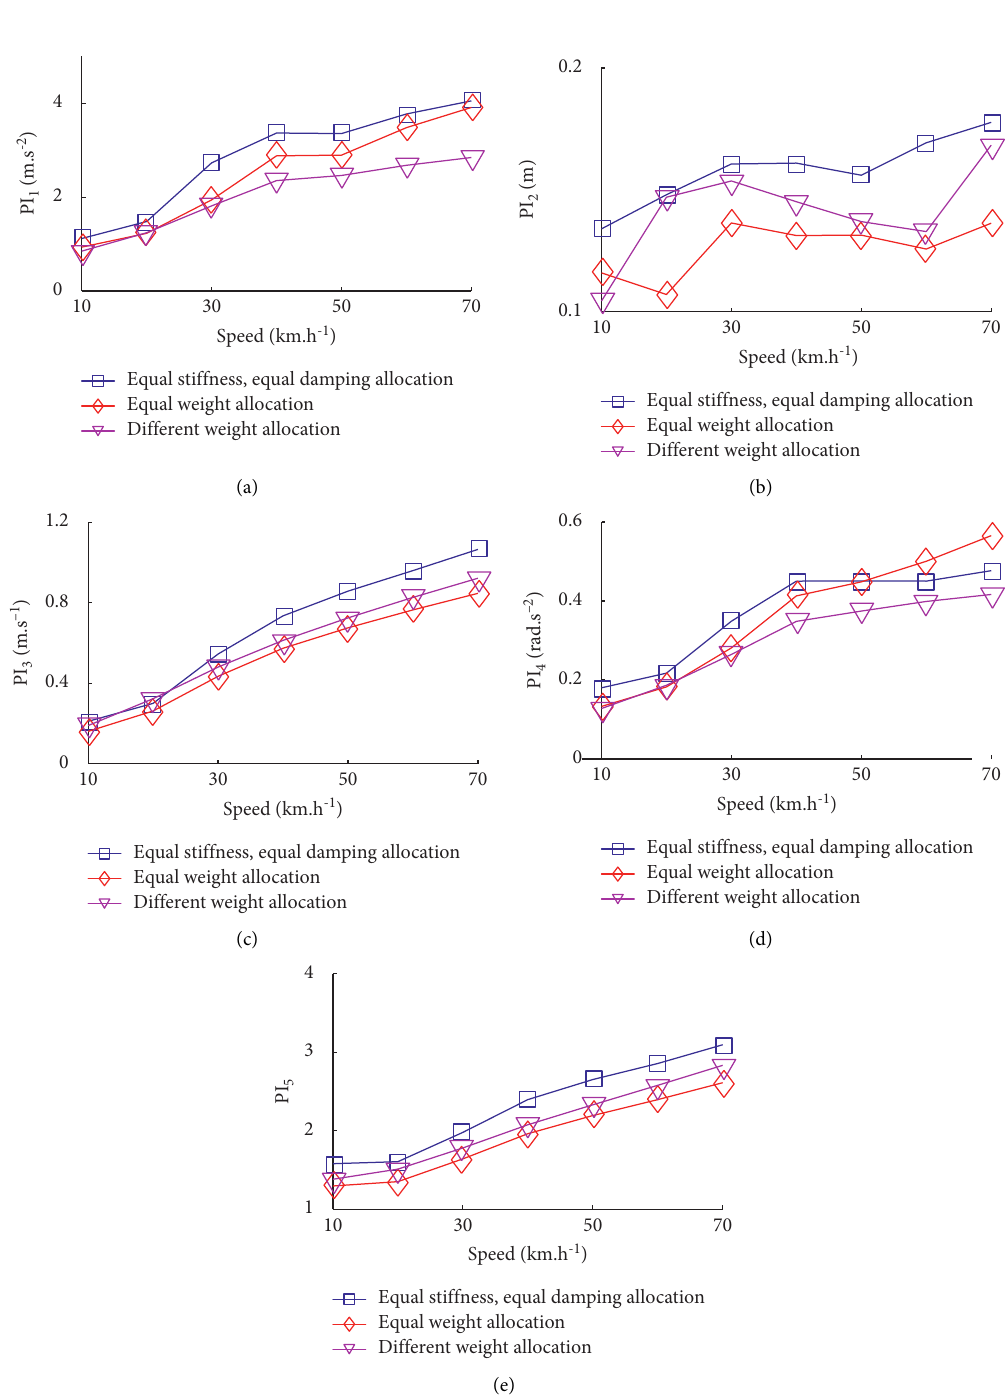
Figure 9: Comparison for the suspension system performance index (on gravel